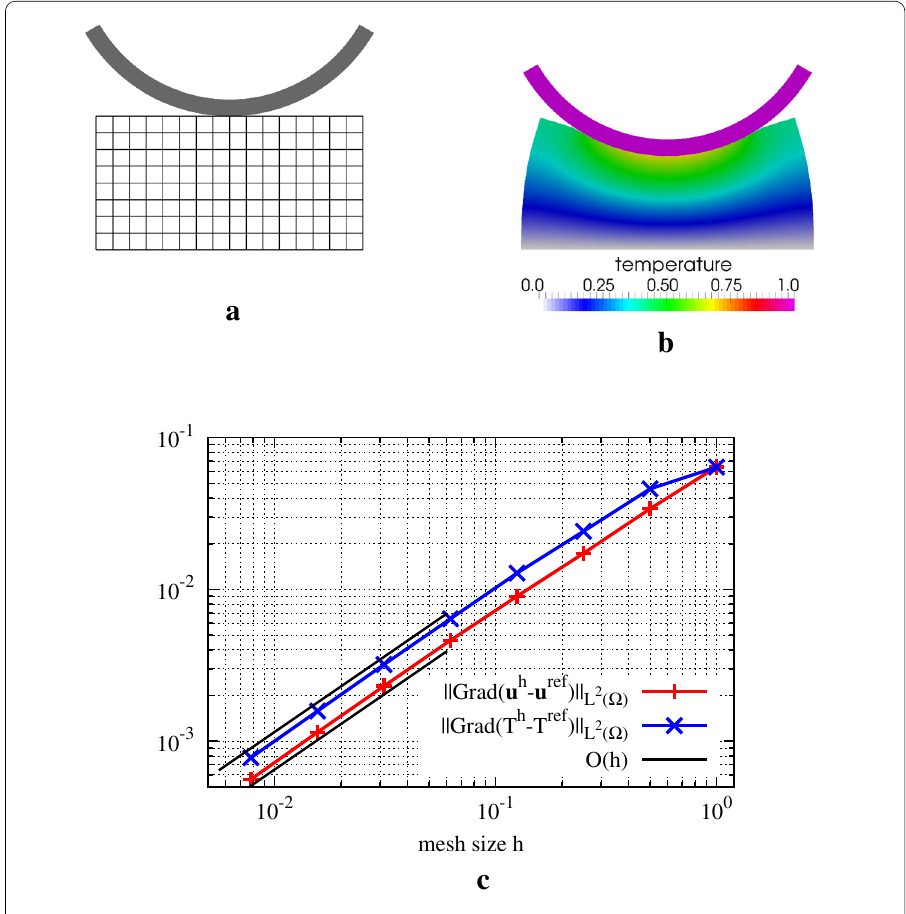
Fig. 4 Thermal contact against rigid obstacle—problem setup and spatial convergence. a Initial mesh for h = 1 / 8 . b Deformed mesh and temperature distribution for h = 1 / 8 . c Convergence of H 1